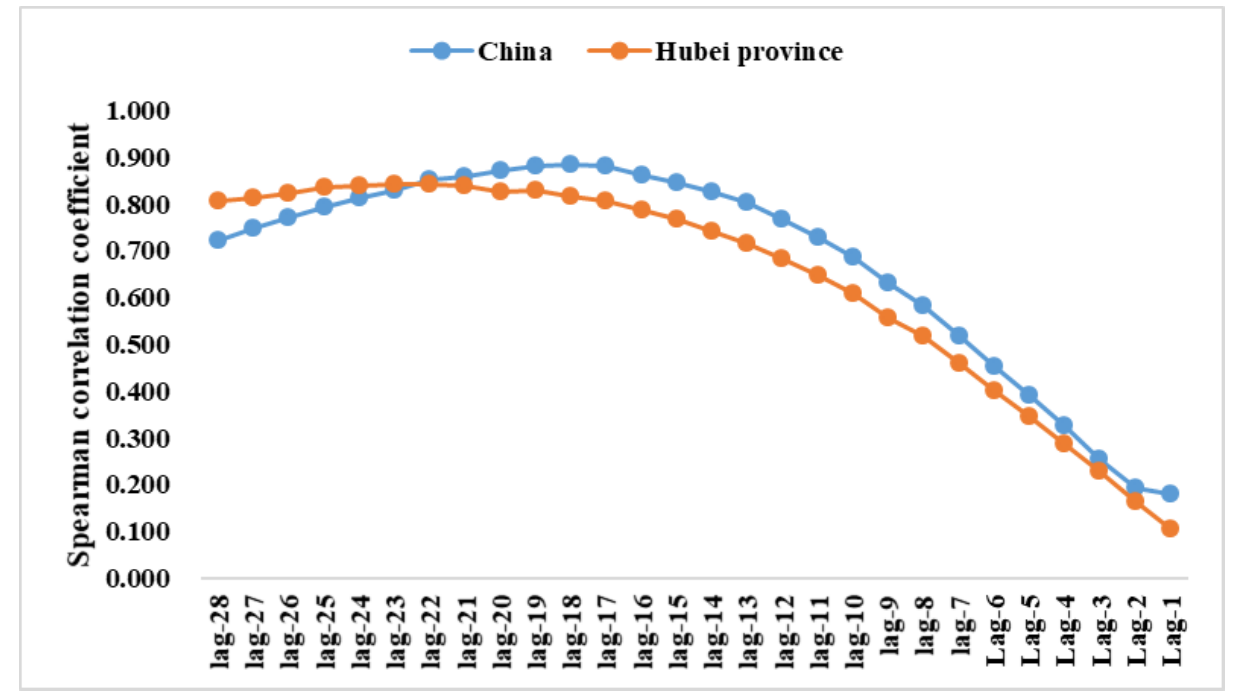
Figure 4. The correlation between Baidu Index and new cured and discharged cases in Hubei province and